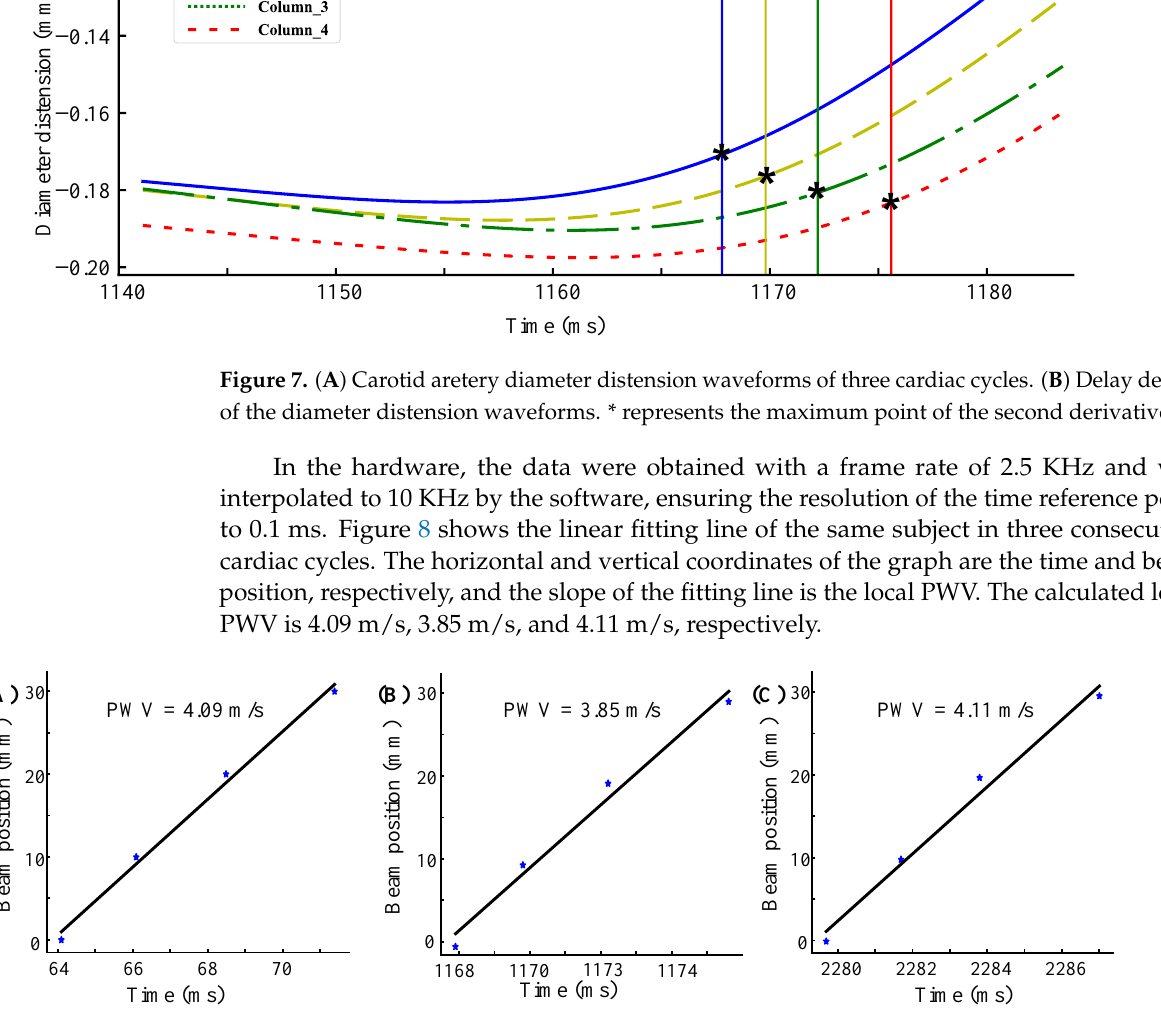
Figure 8. Time reference points (blue star) plotted as a function of transducer positions as well as linear fitting lines (black line). ( A – C ) were measured from three consecutive cardiac cycles of subject 2 (Trial 2). Figure 9 shows the beat-to-beat local PWV for 15 cardiac cycles of three subjects. The solid red line and the dotted black line are the mean and the mean ± standard